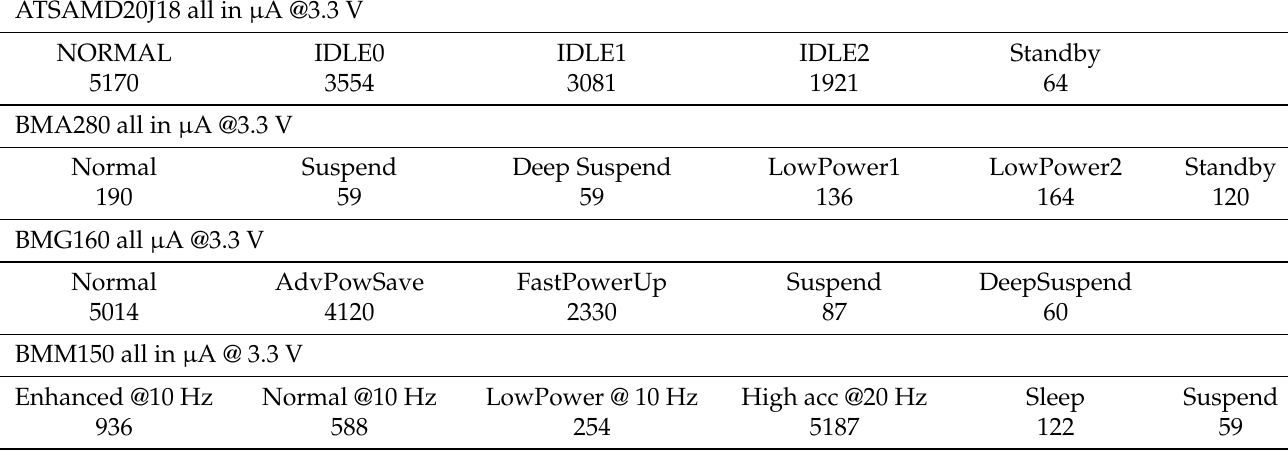
Table 2. Measured power